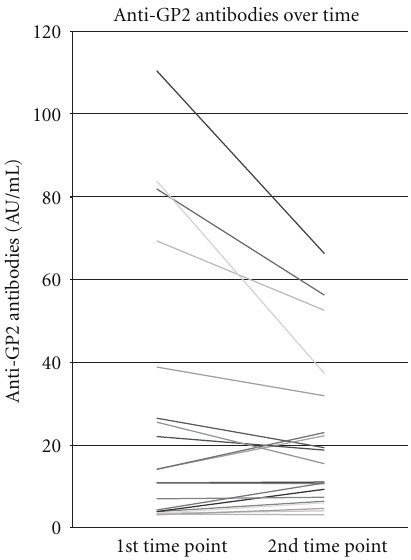
Figure 6: Behaviour of anti-GP2 antibodies during follow up in 20 randomly selected patients with Crohn’s disease (CD), including 8 anti-GP2 antibody positive at